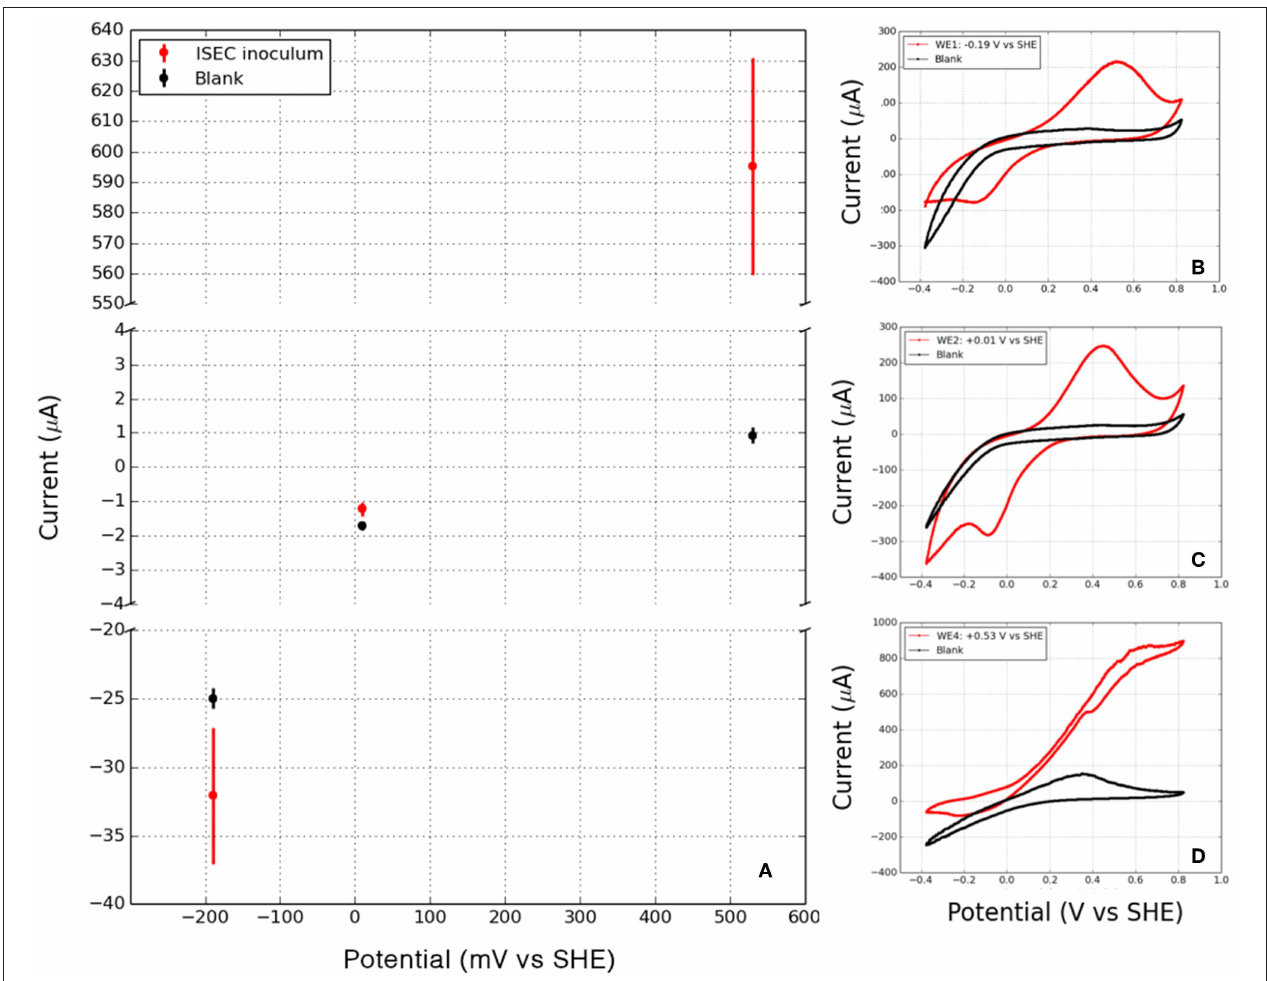
FIGURE 4 | (A) Mean cathodic and anodic currents observed in laboratory enrichments at WE1 ( − 0.19V vs. SHE), WE2 ( + 0.01V vs. SHE) and WE4 ( + 0.53V vs. SHE). Cyclic voltammetry of the working electrodes (including attached biofilms) and the corresponding abiotic controls (blank) at various potentials: (B) WE1: − 0.19V vs. SHE, (C) WE2: + 0.010V vs. SHE, and (D) WE4: + 0.53V vs. SHE, points to redox activity mediated by the in situ microorganisms.